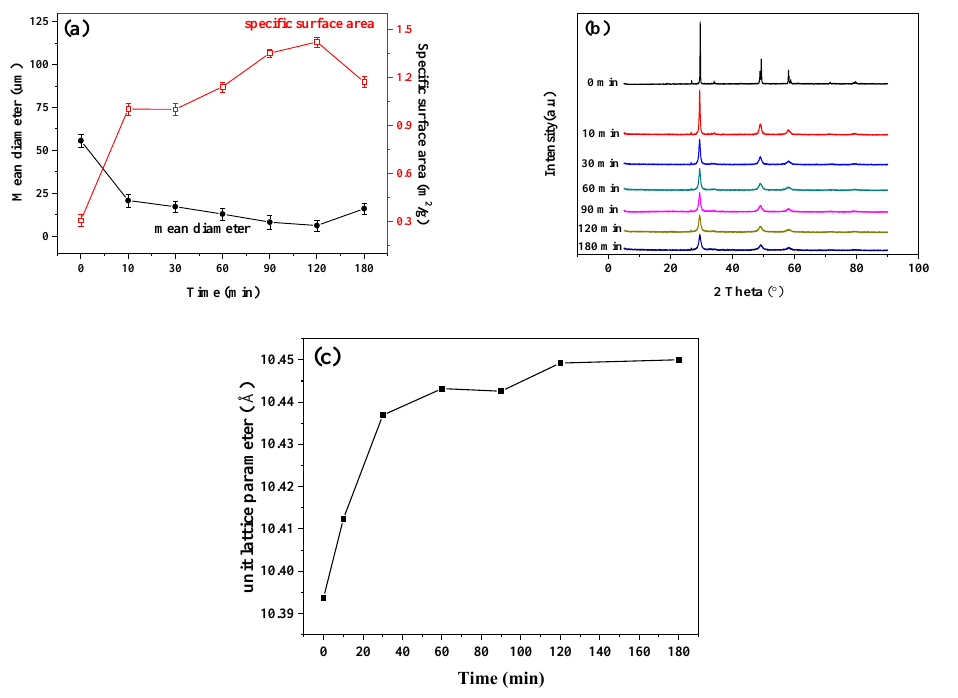
Figure 2. Mean diameter and specific surface area ( a ), XRD spectra ( b ) and unit lattice parameter